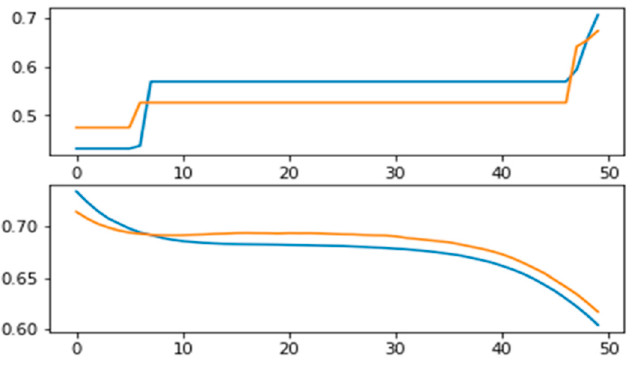
Figure 6. Training and validation accuracy (top) and loss (down) for the human aura module.